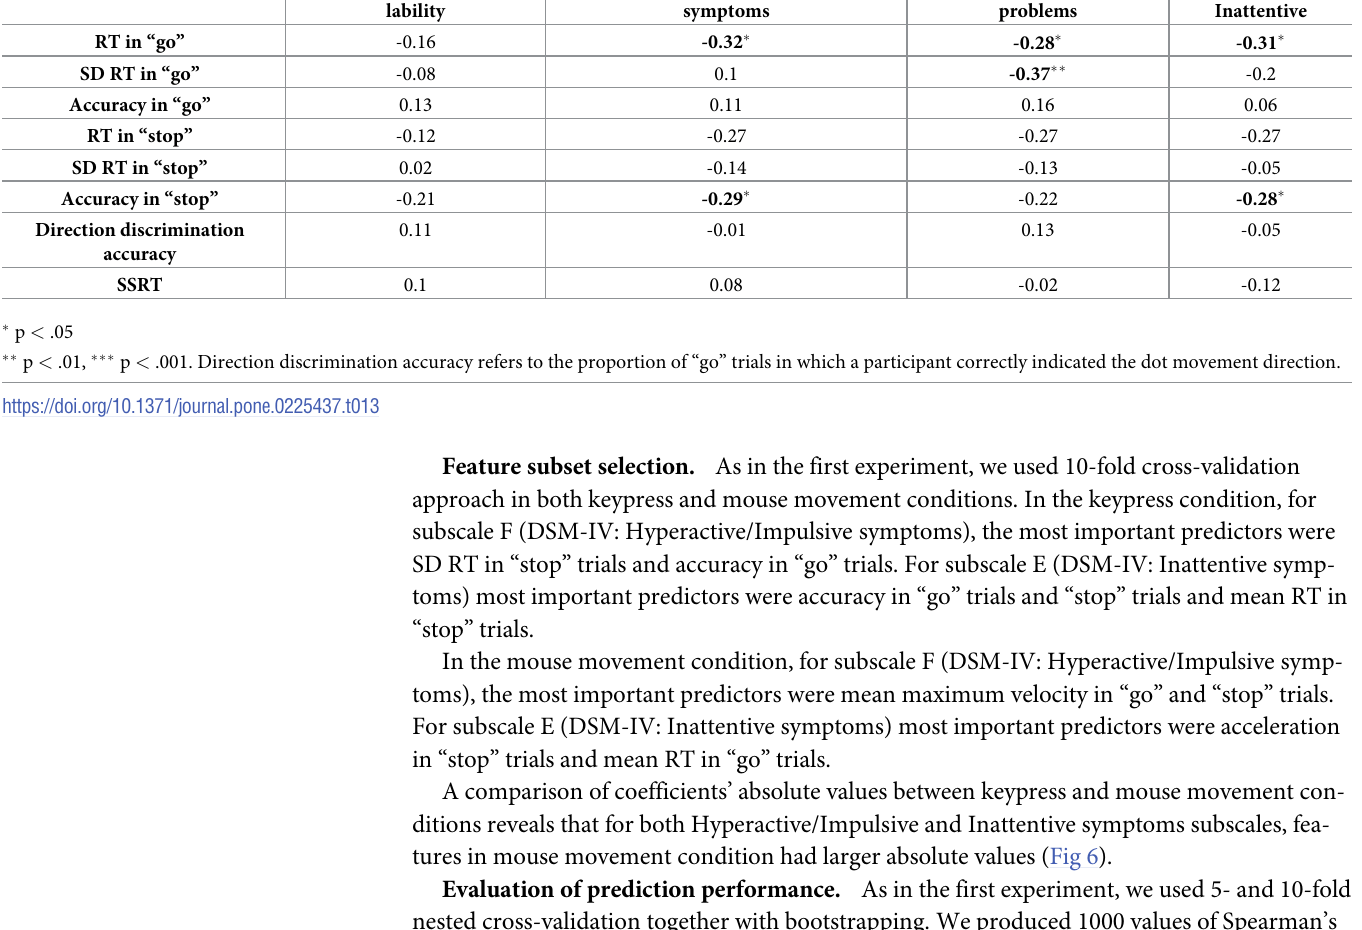
Table 13. Values of Spearman’s ρ for correlations between simple RT/ accuracy-based measures and impulsivity/inattention measures in mouse movement condition. Impulsivity/Emotional lability